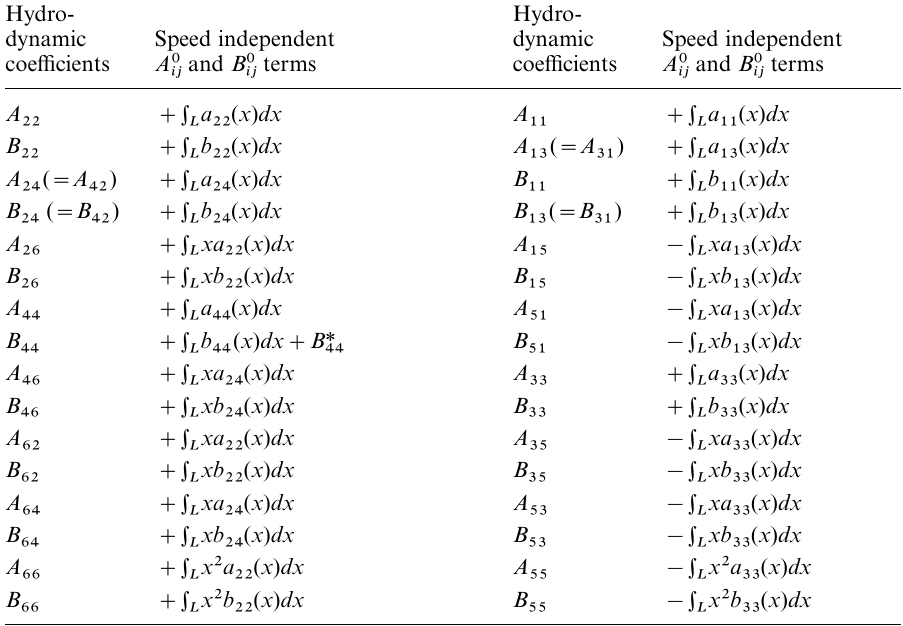
Table 2. S-T-F Strip Theory Coe ffi